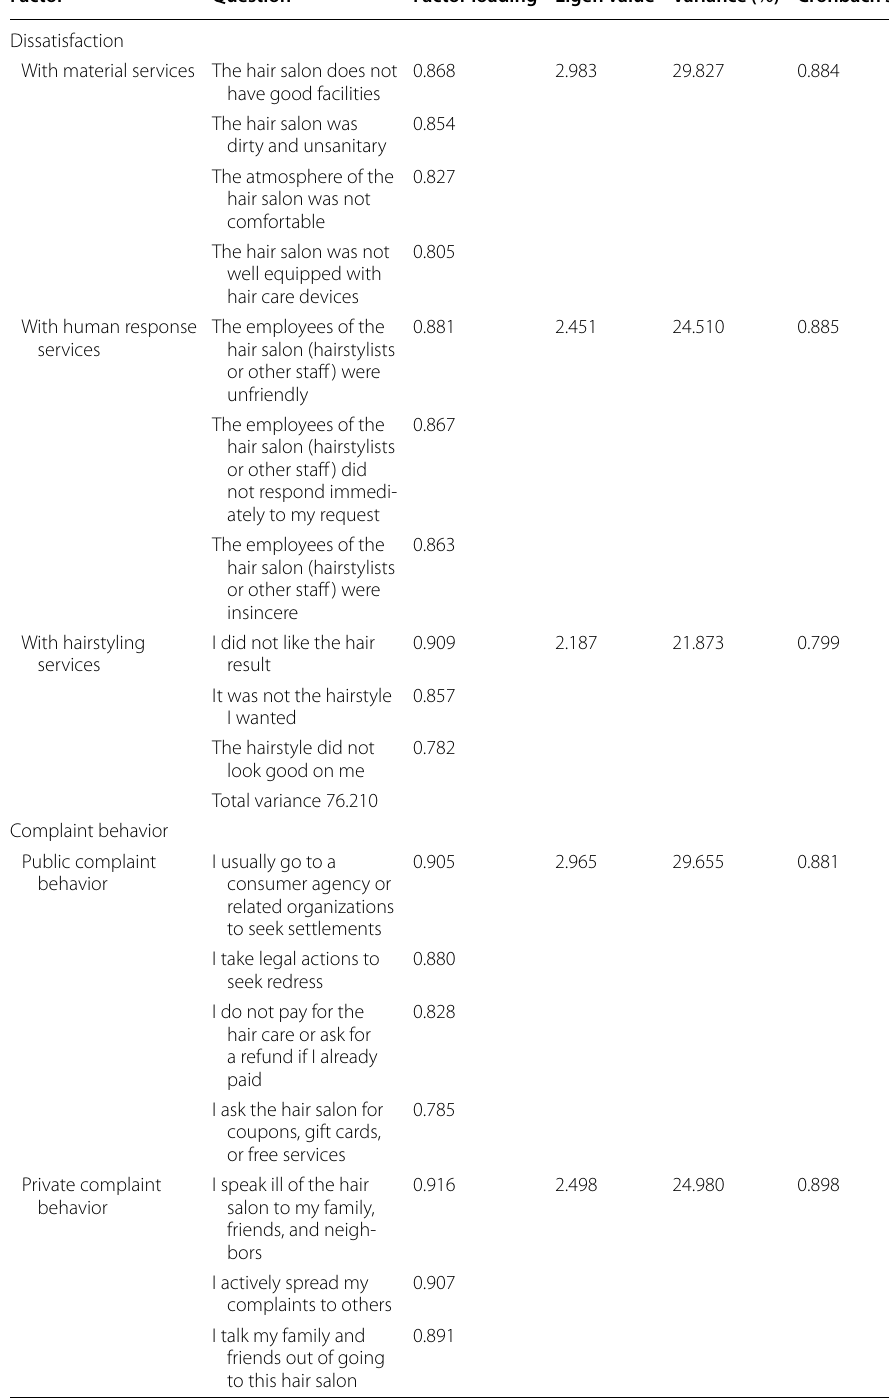
Table 1 Result of exploratory factor analysis Factor Question Dissatisfaction With material services The hair salon does not have good